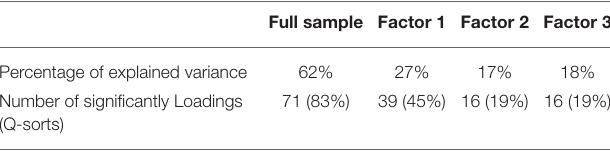
TABLE 2 | Overview of explained variance and number of